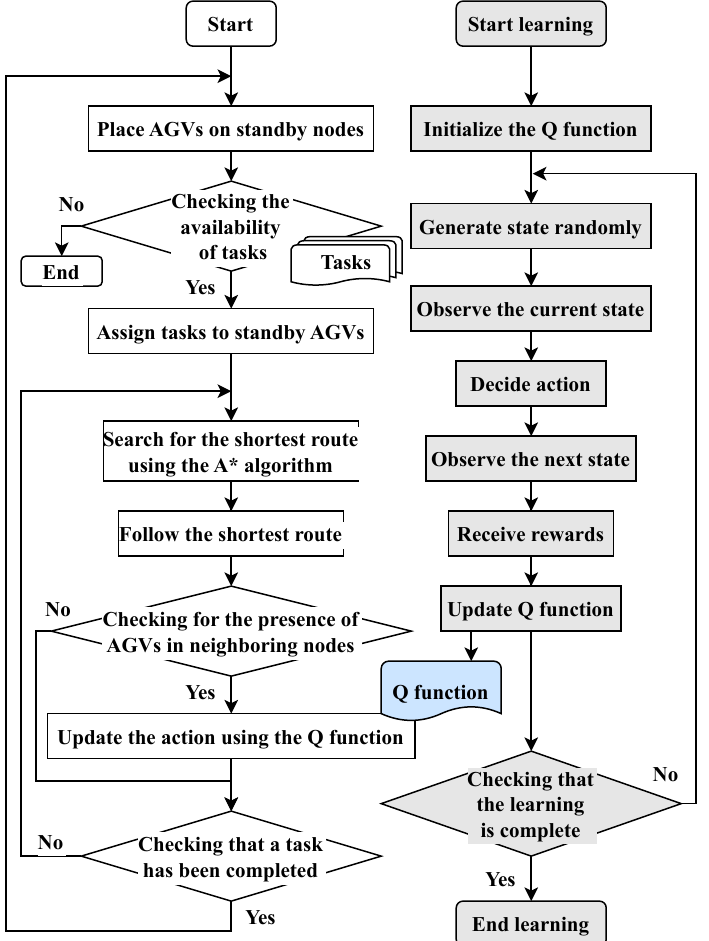
Figure 7. Flowchart of the proposed algorithm. The flowchart on the right side shows the process of building a learning model for Q–learning. The flowchart on the left side shows the process of planning a route using the Q–learning training model that was